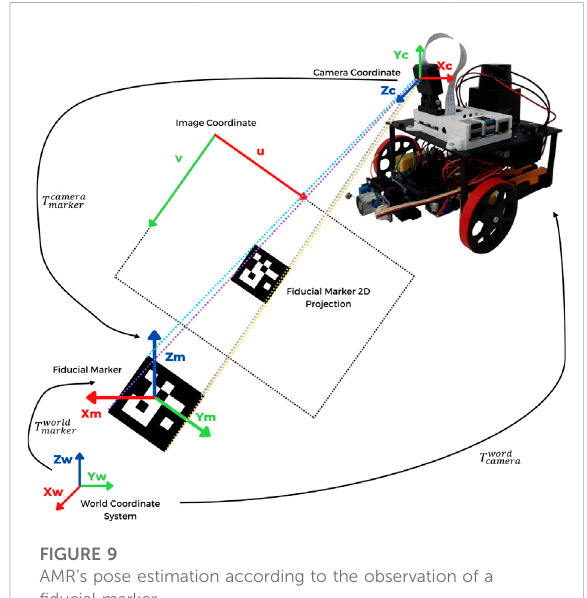
FIGURE 9 AMR ’ s pose estimation according to the observation of a fi ducial